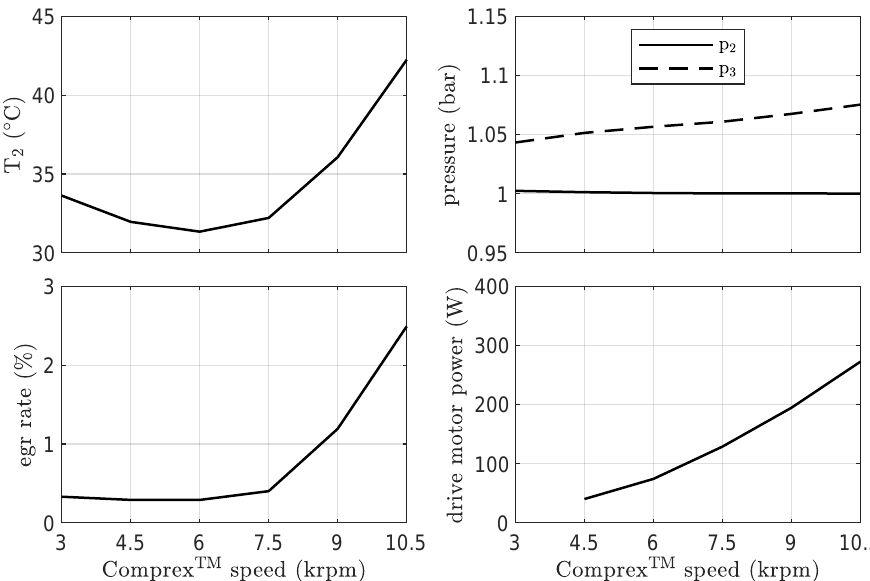
Figure 4. Variation of the rotor speed at 2250 rpm and 50 Nm, operation with both cycles.